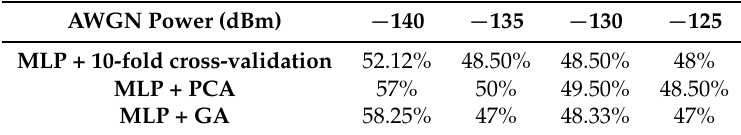
Table 12. ML-based prediction results for AMC3.